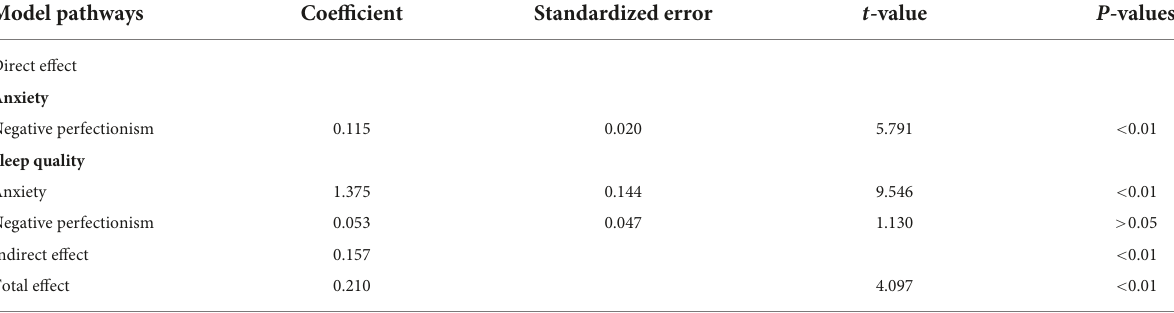
TABLE 2 Mediating effect of anxiety.